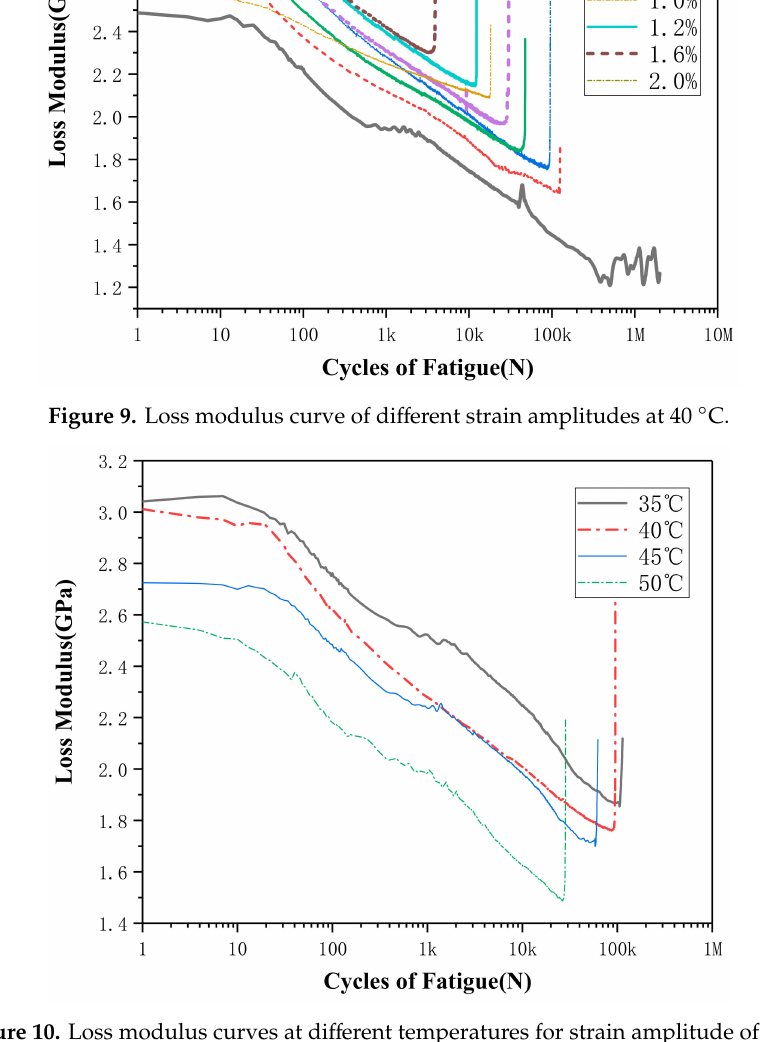
Figure 10. Loss modulus curves at di ff erent temperatures for strain amplitude of